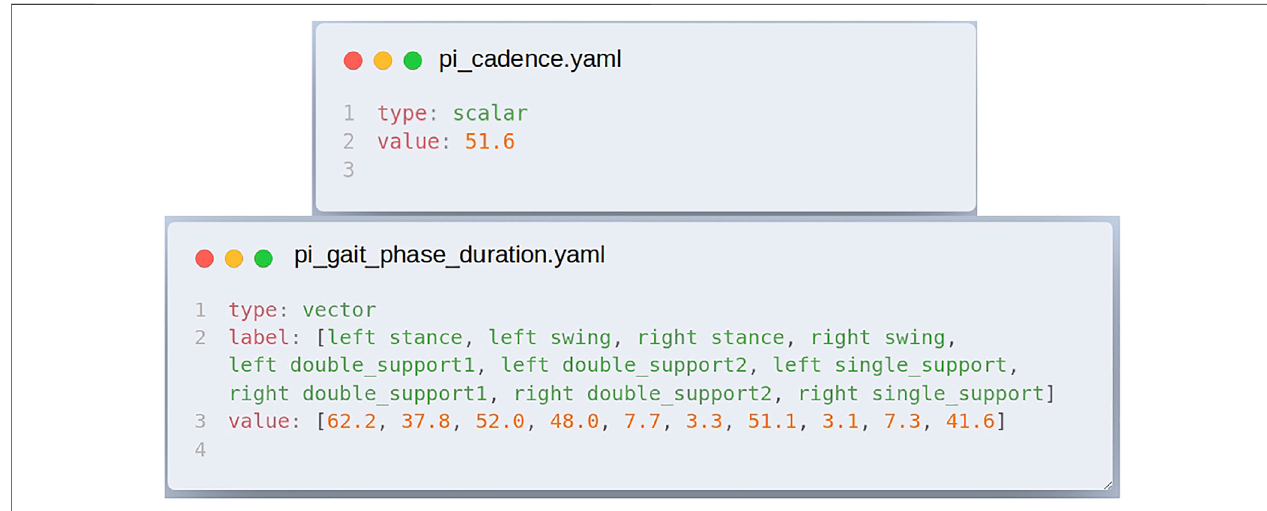
FIGURE 3 | Example of performance indicators (PI) output score fi les, obtained with the walking on slope algorithm. Scores are stored as YAML fi les to ease potential post-processing.